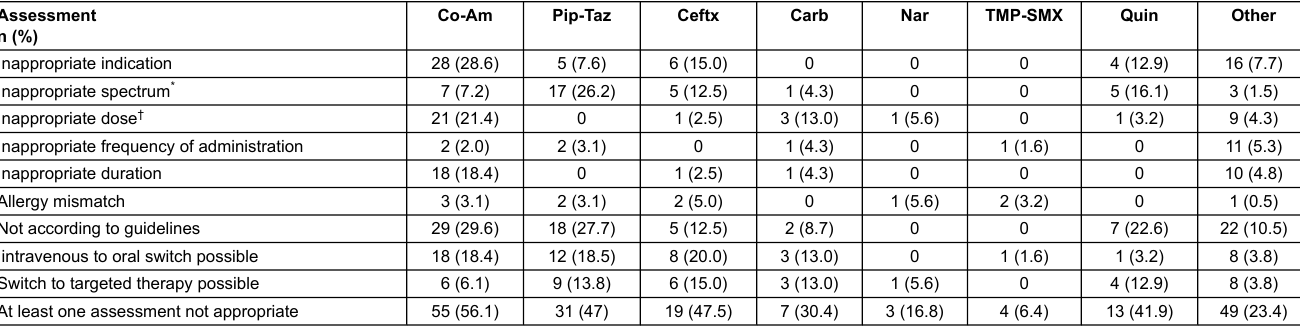
Table 4: Assessment of appropriateness according to the prescribed antimicrobial treatment (n = 548). Data are shown in detail only for the most frequently used agents. Assessment n